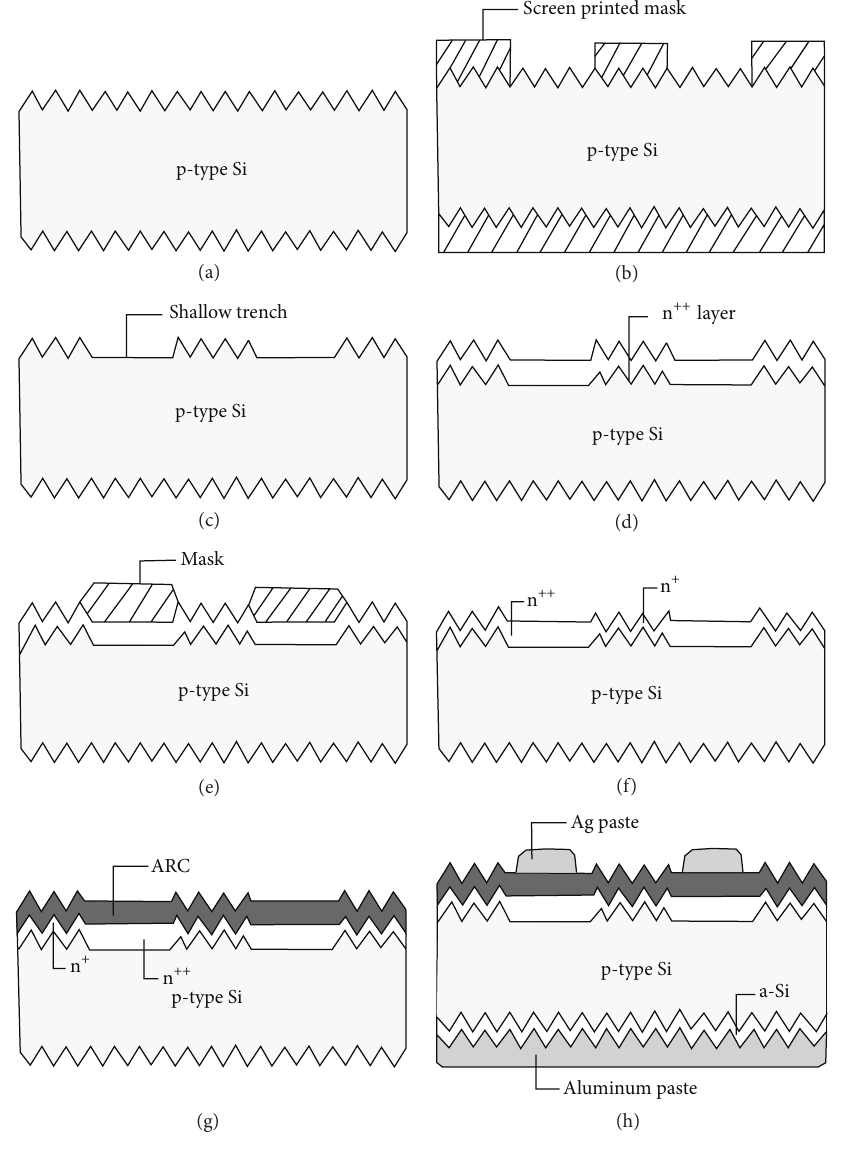
Figure 2: Fabrication steps for selective emitter solar cells in this